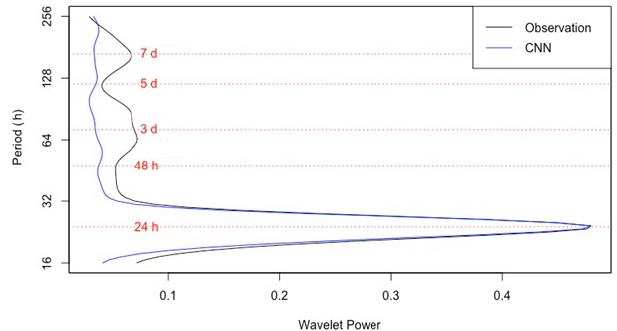
Figure 3. Wavelet power for various time periods (modes) for CNN predictions and